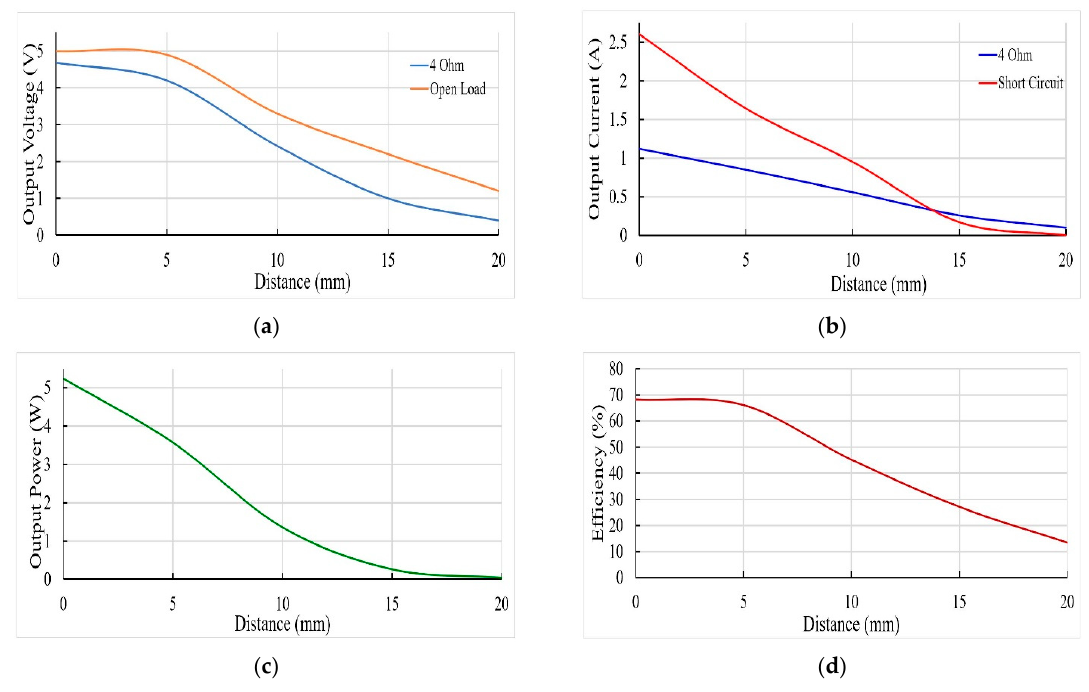
Figure 17. The developed wireless power transmitter characteristics: ( a ) the output voltage characteristics; ( b ) the output current characteristics; ( c ) the output power characteristics; ( d ) the efficiency characteristics. e ffi ciency